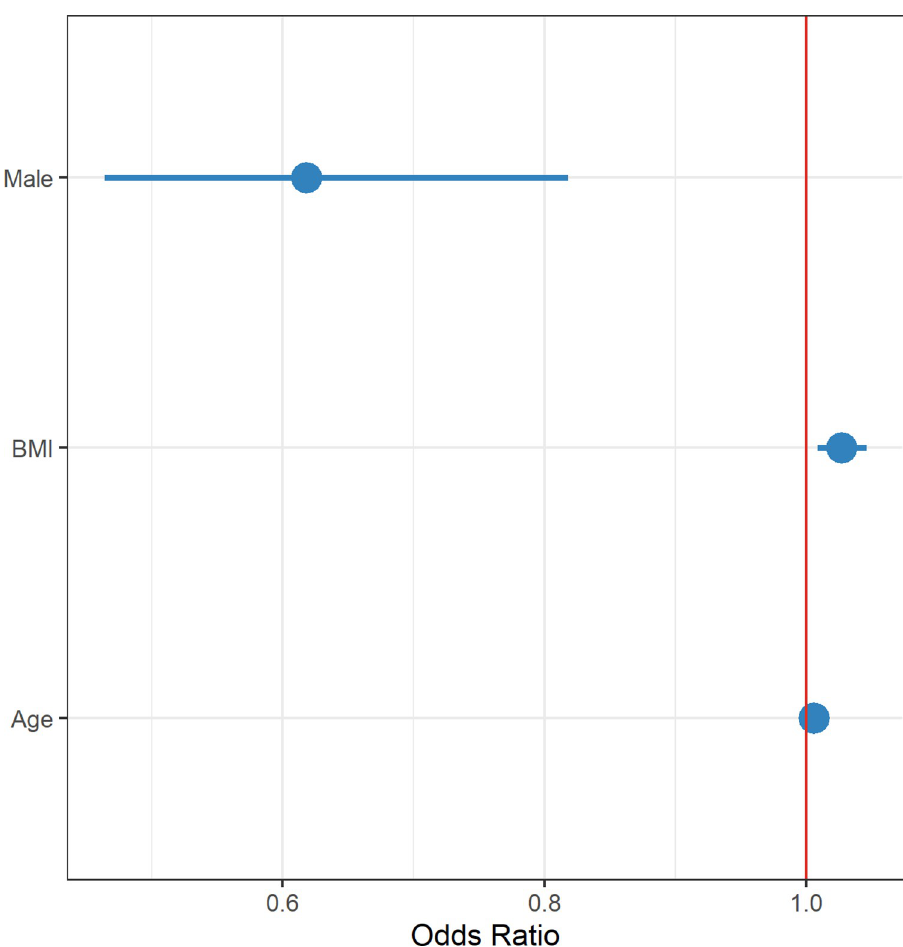
Fig 4. Predictors of using health services when having post-COVID-19 syndrome symptoms (analysis for 277 patients with post-COVID-19 syndrome and further use of health services). Higher BMI associated with increased use, whilst being a man associated with less use of